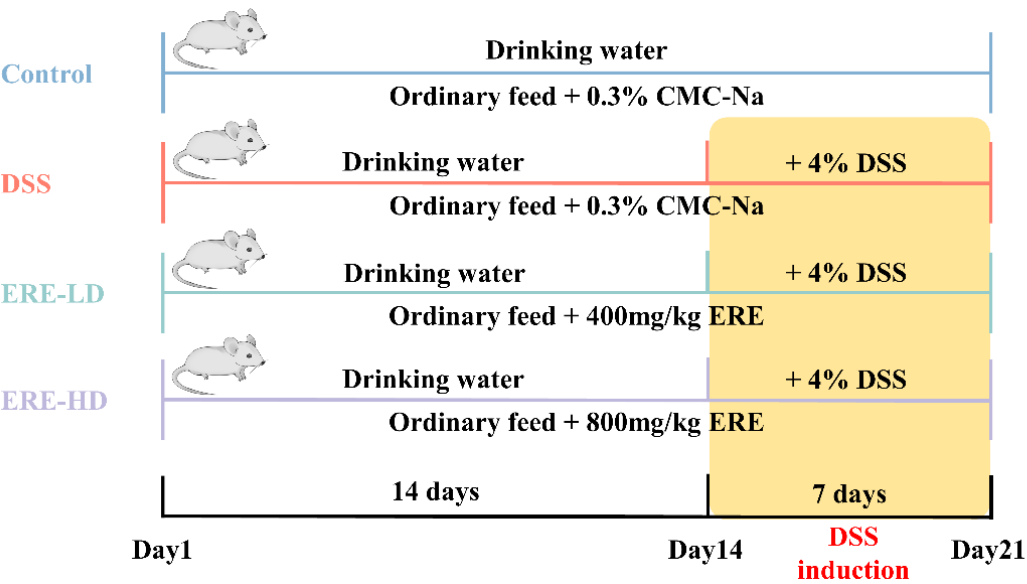
Figure 2. The schematic diagram of in vivo experimental design.